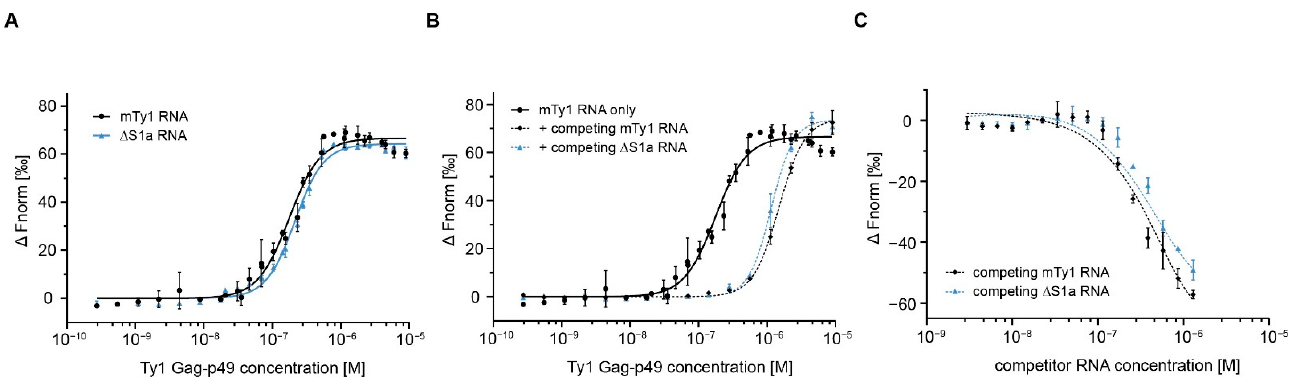
Figure 5. Role of the 5 (cid:48) pseudoknot in Gag-Ty1 RNA interactions. ( A ) Dose–response binding curves of Ty1 Gag-p49 with mTy1 RNA (black) and ∆ S1a (blue) at 150 mM NaCl. ( B ) Dose–response binding curves Gag-p49-mTy1 RNA interactions in the presence of competing mTy1 RNA (black, dashed line) or ∆ S1a RNA (blue, dashed line) in 10-fold molar excess. mTy1 RNA binding by Ty1 Gag-p49 in 150 mM NaCl lacking competitor is used as a control (black, solid line). ( C ) Dose–response binding curves of Ty1 Gag-p49 to mTy1 RNA in the presence of an increasing concentration of competing mTy1 RNA (black) or ∆ S1a RNA (blue).